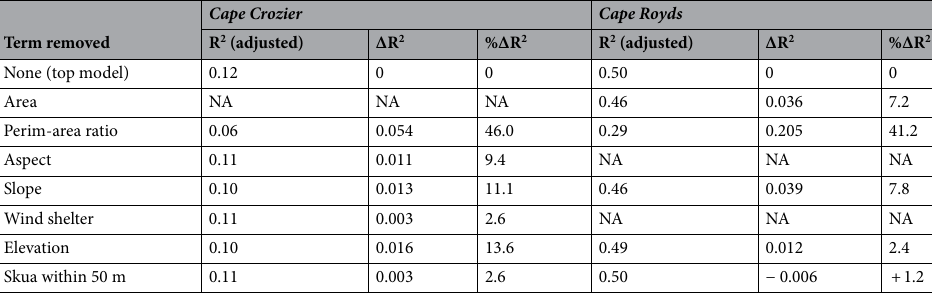
Table 4. Variable importance for each covariate in the top model at Cape Crozier and Cape Royds, Ross Island, Antarctica, 2014–2017. The ΔR 2 is the difference between the adjusted R 2 of the top model and the adjusted R 2 of the top model with the variable of interest removed. %ΔR 2 is the percent decrease in the original R 2 when that variable was removed. The plus sign for the skua proximity variable at Cape Royds indicates a slight increase in the adjusted R 2 when that variable was removed. Flow accumulation does not appear in the table because it was not included in either top model.